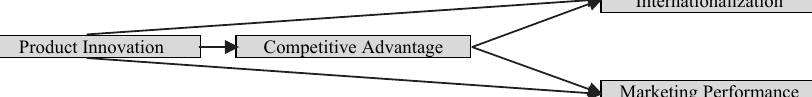
Fig. 1. The proposed